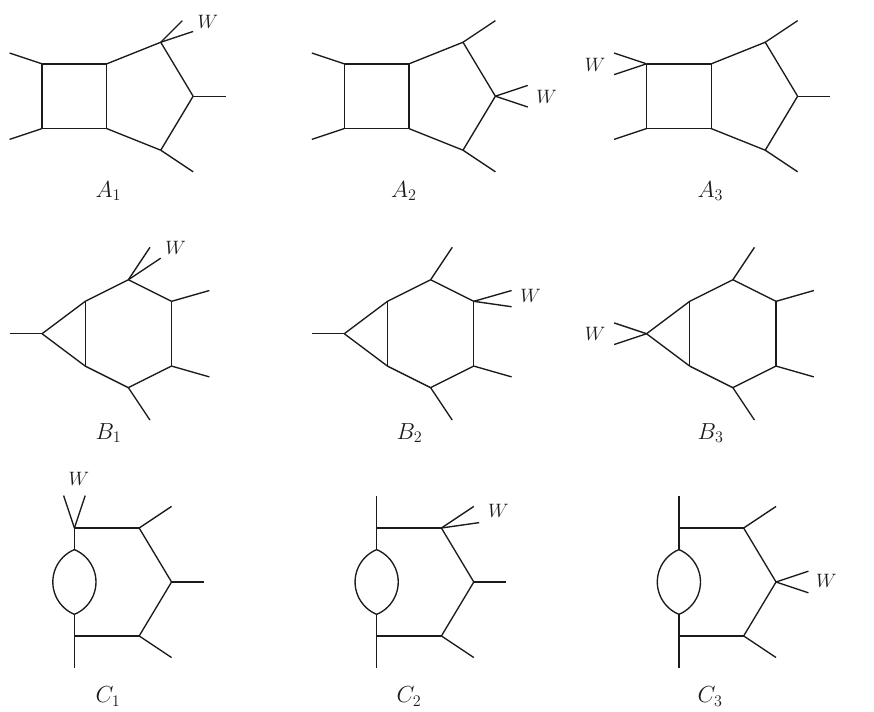
Figure 1 . Independent maximal cut topologies contributing to planar W + 4 parton scattering at two-loops. The full set of 15 maximal cuts can be obtained by including 2 permutations of A 1 , A 3 , B 1 , B 2 , C 1 and C 2